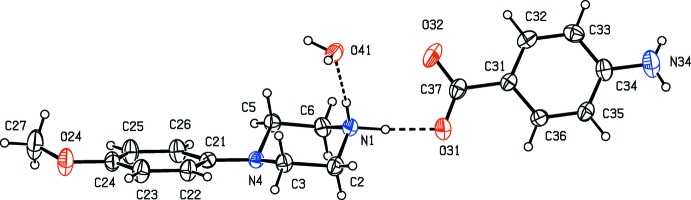
The independent components of compound (IV) showing the atom-labelling scheme and the hydrogen bonds, drawn as dashed lines, within the selected asymmetric unit. Displacement ellipsoids are drawn at the 30% probability level.